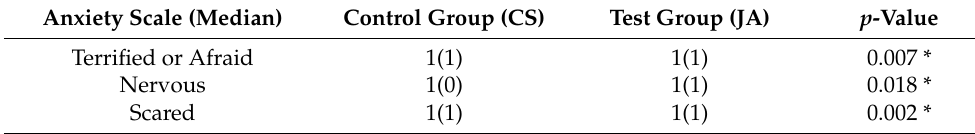
Table 2. Anxiety scores according to Beck’s Anxiety Inventory in CS and JA group. Anxiety Scale (Median) Control Group (CS) Test Group (JA) p -Value Terrified or Afraid 1(1) 1(1) 0.007 * Nervous 1(0) 1(1) 0.018 *